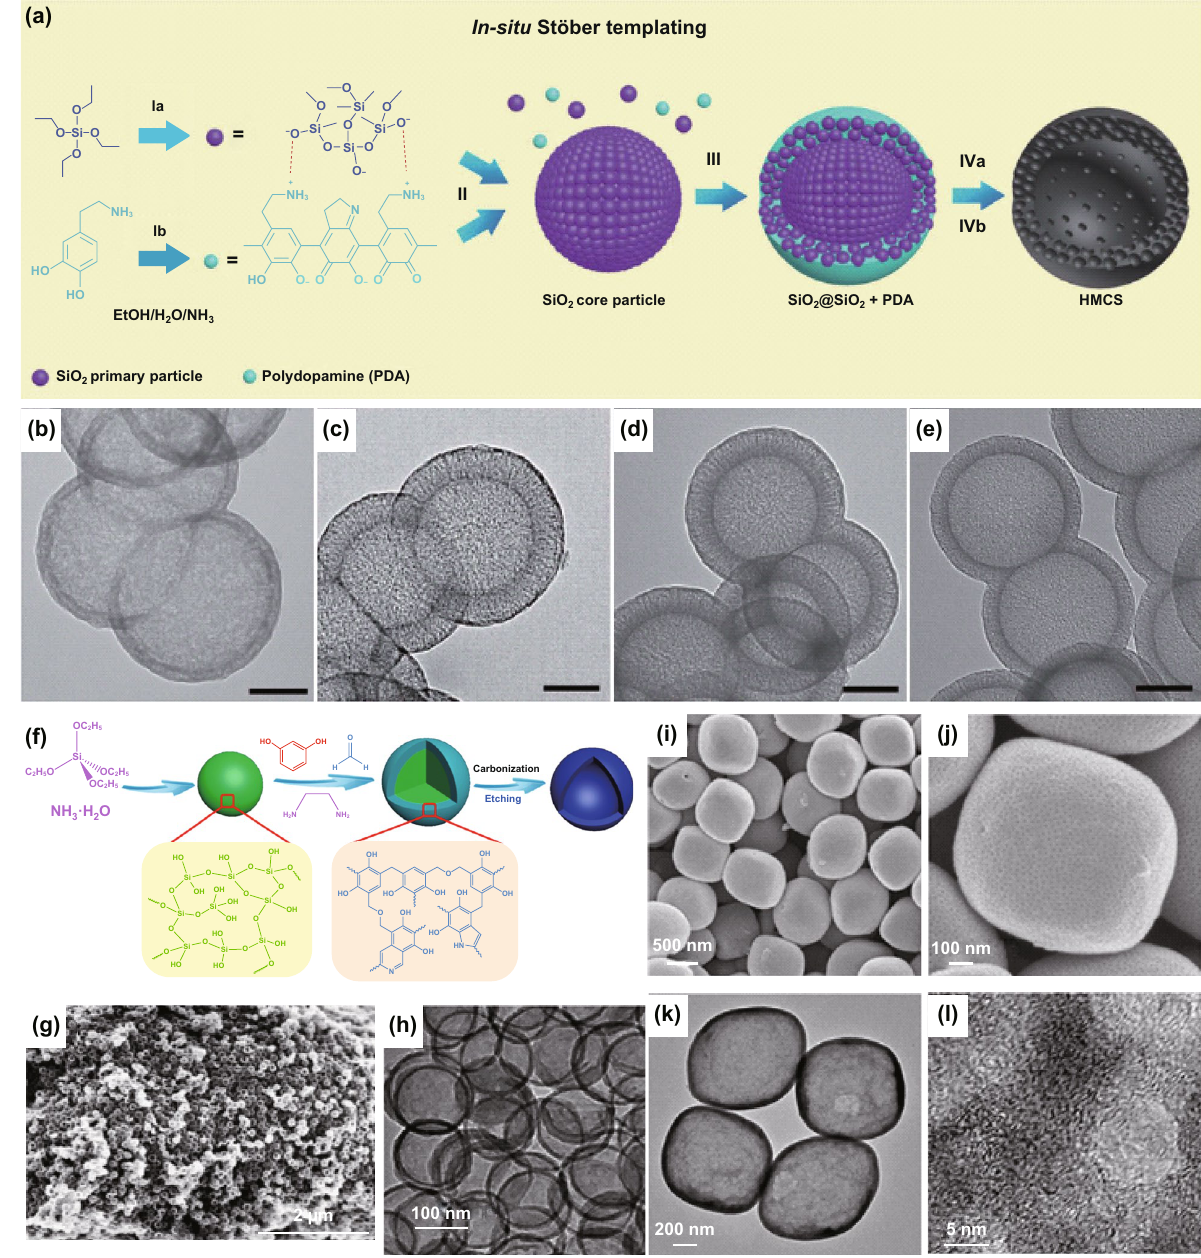
Fig. 3 a Schematic illustration of the synthesis process of HMCS by using SiO 2 as hard templates, b–e TEM images of the cavity and shell thickness of the as-fabricated HMCS, scale bars: 100 nm. Reproduced with permission from Ref. [36]. Copyright 2016, Royal Society of Chem- istry. f Schematic illustration of the synthesis process of NC, g SEM, and h TEM images of NC. Reproduced with permission from Ref. [40]. Copyright 2017, Elsevier. i , j SEM and k , l TEM images of the carbon colloidosome shells. Reproduced with permission from Ref. [41]. Copy- right 2016,